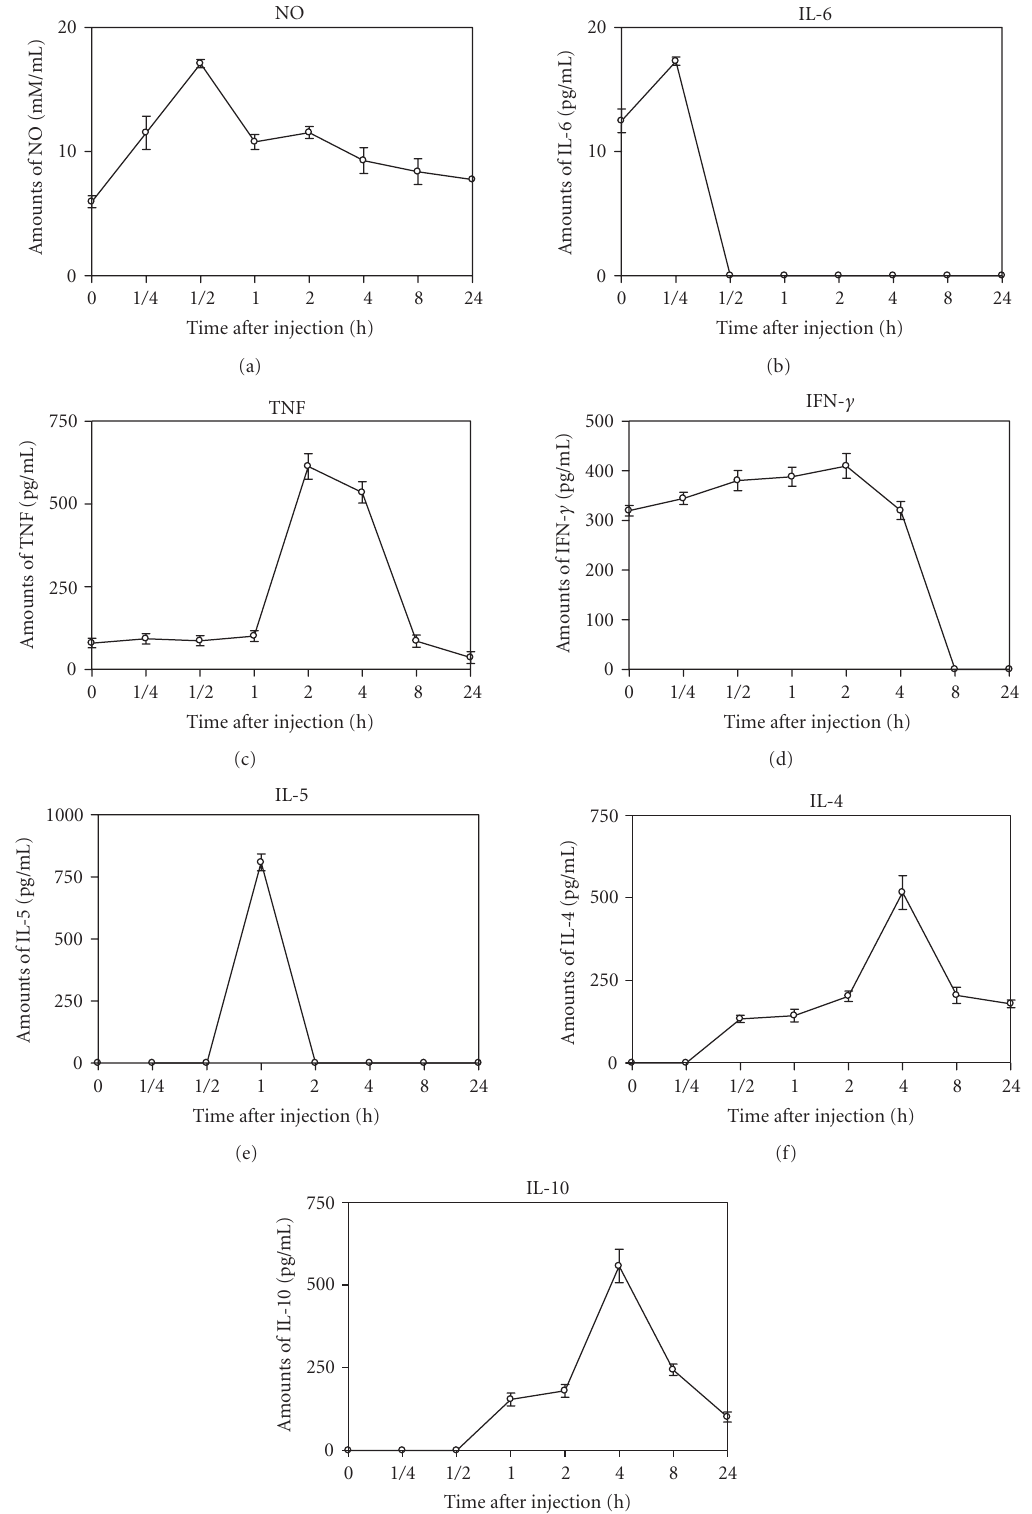
Figure 6: Kinetics of mediator secretion . Groups of female mice from BALB/c strain, 13–15 g of body weight, were i.p. injected with 1 LD 50 of Cdt. After di ff erent times the animals were bled and the levels of cytokines present in the serum were determined as described in materials and methods (see Section 2). Each point represents the mean value of the results obtained from two independent experiments conducted with five to fifteen animals each. Statistical di ff erences between the injections were ( P < .